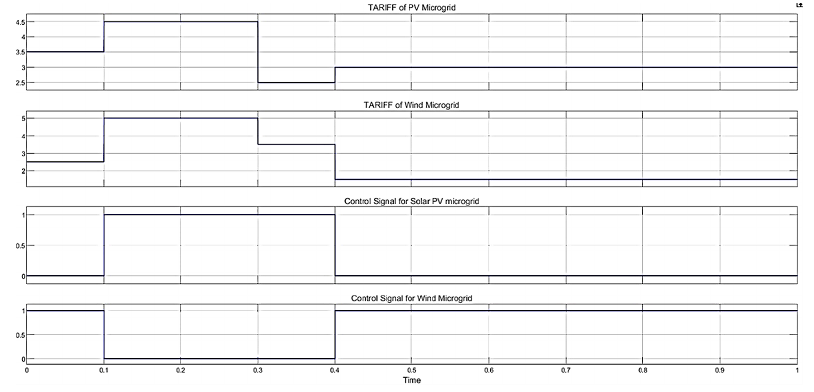
Figure 18. Tariff control signal.